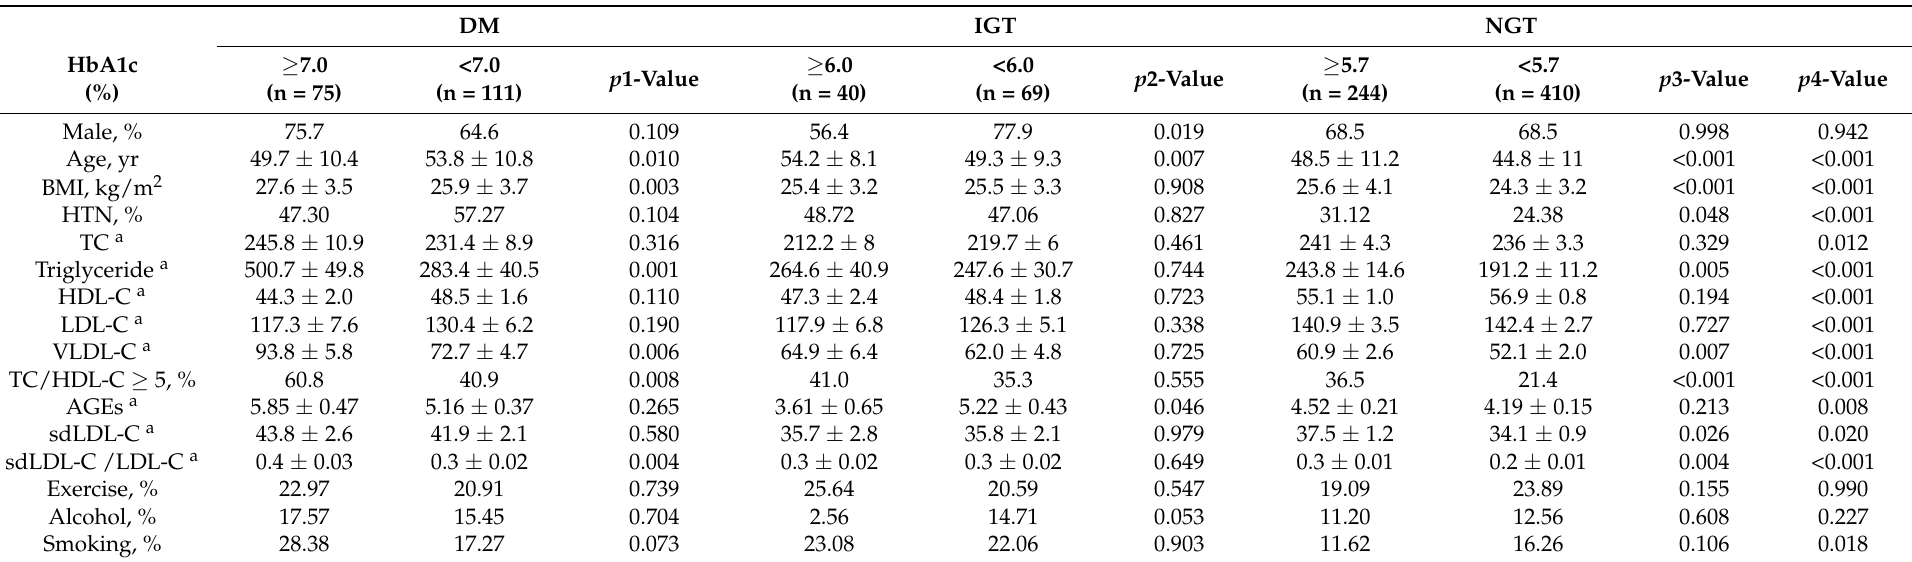
Table 3. Cardiovascular characteristics of clinical subjects after OGTT stratified by glycated hemoglobin levels. IGT